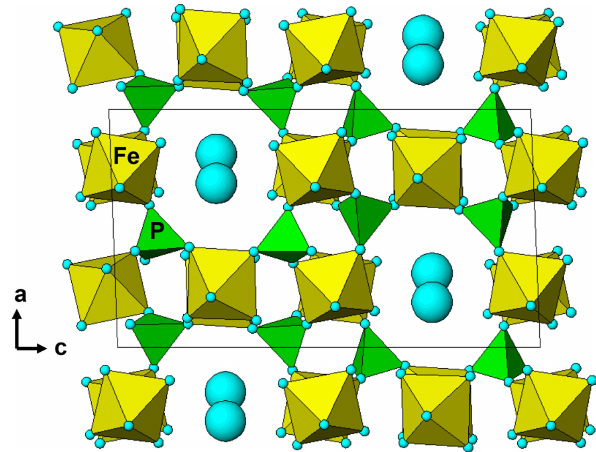
Figure 7. A [010] projection of the crystal structure of allanpringite, showing eight-sided channels occupied by water molecules (blue spheres). The channels are potential locations for extra-framework hydrated cations.